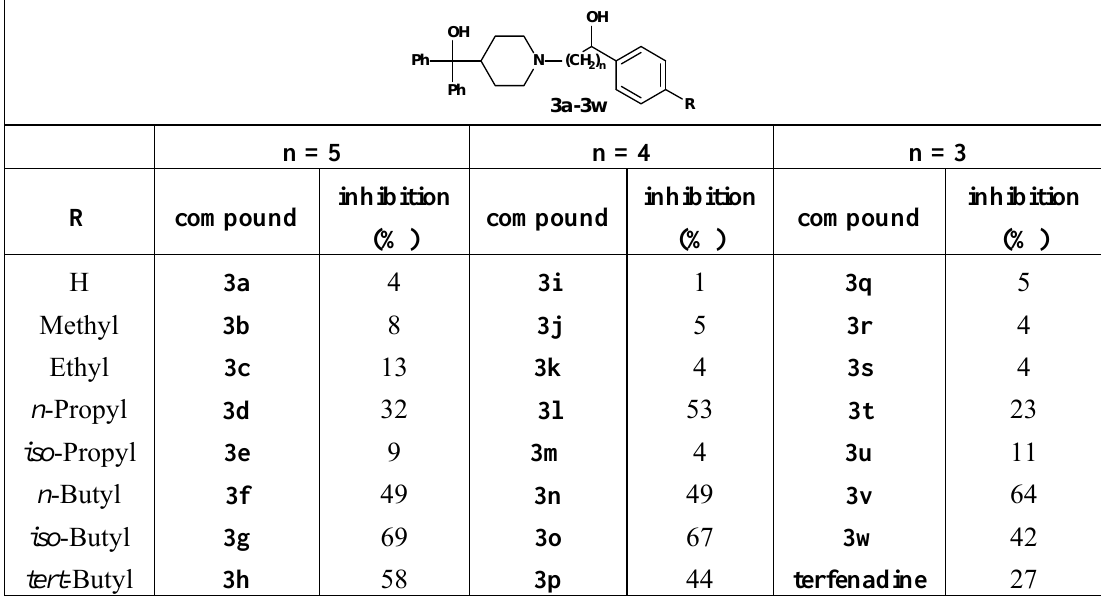
Table 5. Inhibition of protein interaction in AN assay by compounds 3a - 3w (concentration: 50 µM, standard deviation ≤ 6